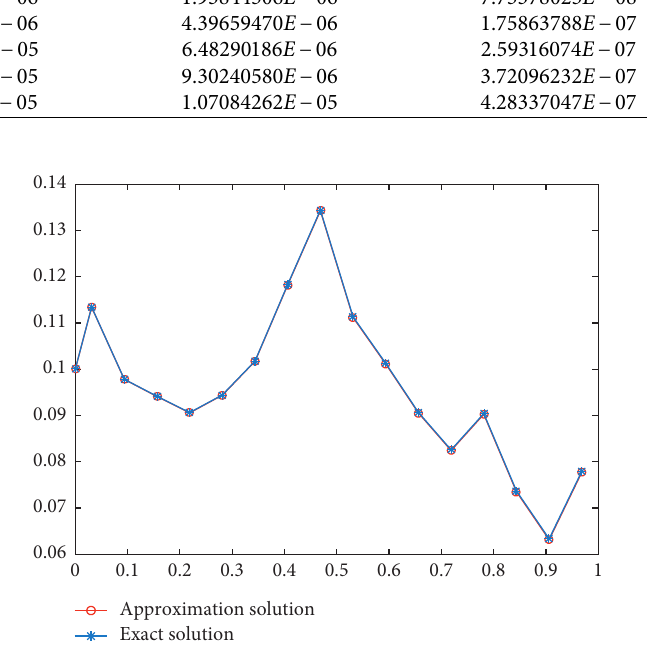
Figure 1: Simulation result of Example 1 for H � 0 . 6 and m � 16.